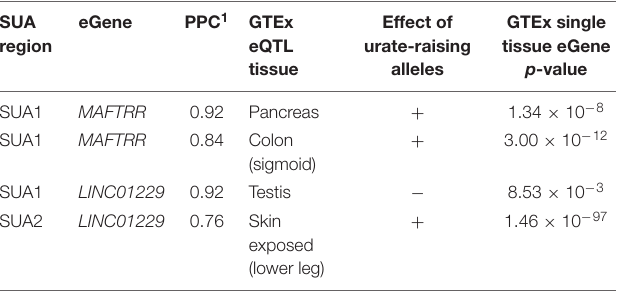
TABLE 2 | Colocalized GTEx eQTL and SUA upstream of MAF.